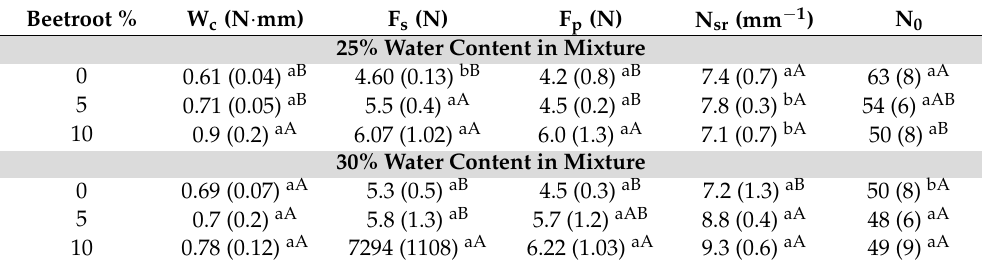
Table 3. Mean values (and standard deviations) of texture parameters of expanded product: crispness work (W c ), average specific force of structural ruptures (F s ), average puncturing force (F p ), spatial frequency of structural ruptures (N sr ), and number of peaks (N 0